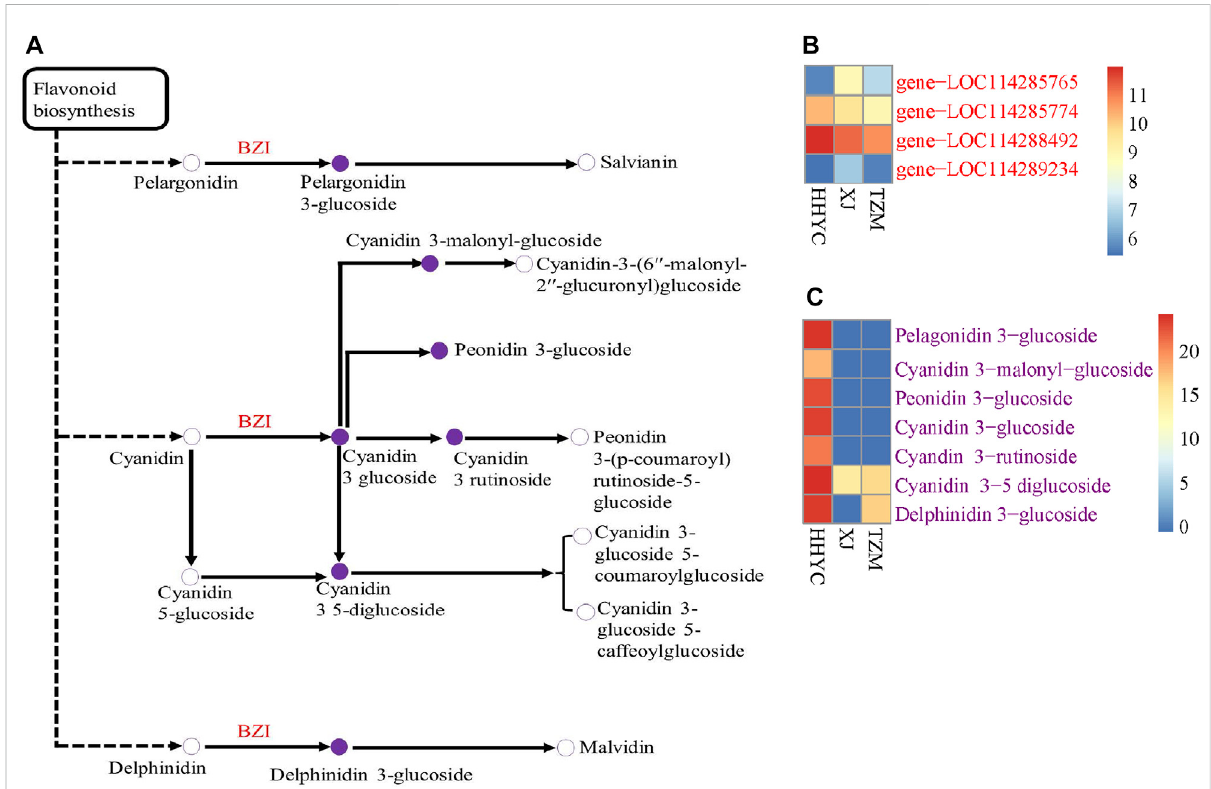
FIGURE 6 Schematic diagram of anthocyanins biosynthetic pathways responsible for color differentiation among C. reticulata (HHYC), C. reticulata ‘ Xuejiao ’ (XJ) and C. reticulata ‘ Tongzimian ’ (TZM). (A) . Heatmap of four anthocyanidin 3-O-glucosyltransferase [EC:2.4.1.115] (BZI) encoded genes. (B) . Heatmap of seven differentially accumulated metabolites. Metabolites with hollow circles were not detected in this study, while those in purple circles were detected in this study. Heatmaps were produced with log2 transformeddata. Color diagram at theright side shows the intensity of the metabolite accumulation or gene